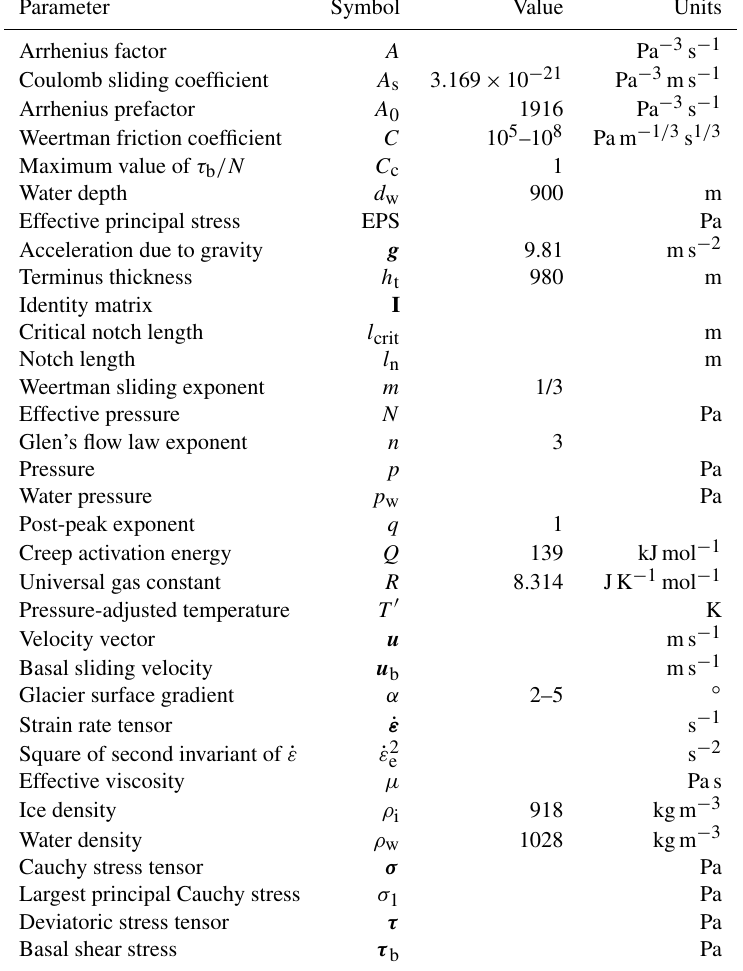
Table 1. Symbols and values of physical and numerical constants and parameters used in this